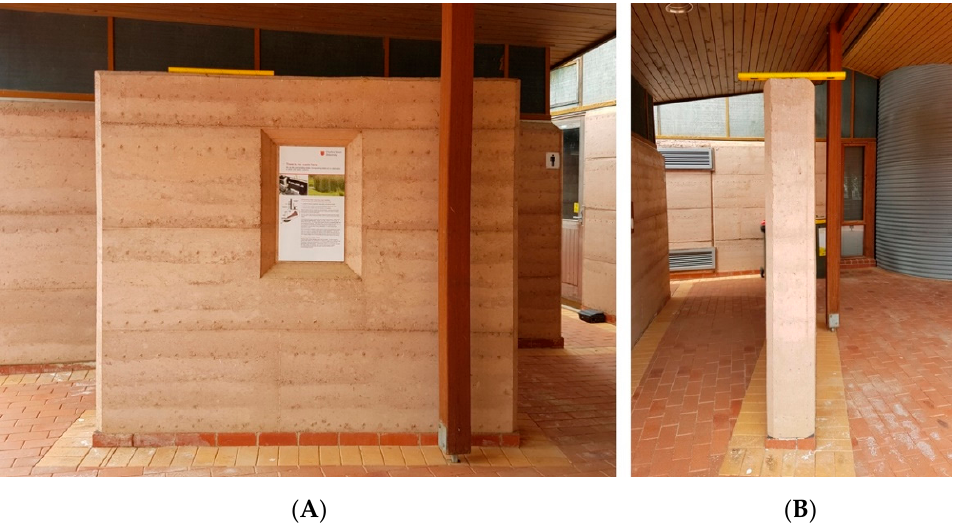
Figure 11. Uncapped, protected wall C1, screening the entrance to the external toilets of building 762: ( A ) frontal view seen from the south; ( B ) sideways view seen from the west.